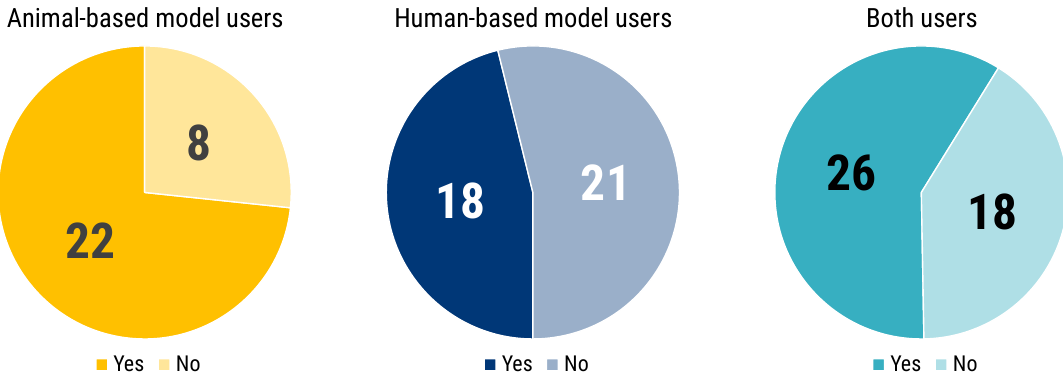
Figure 5. Participants answered the following question, “In your opinion, in order to publish in high-impact factor journals or for business exploitation (industry licensing, etc.) are animal experi- ments necessary to complement in vitro/in silico human- based experimental models?”. The pie charts show the number of respondents answering “Yes” (blue) and “No” (red) segmented by re- searchers’ use of animal - (shades of yellow) or human-based (shades of blue) or both models (shades of